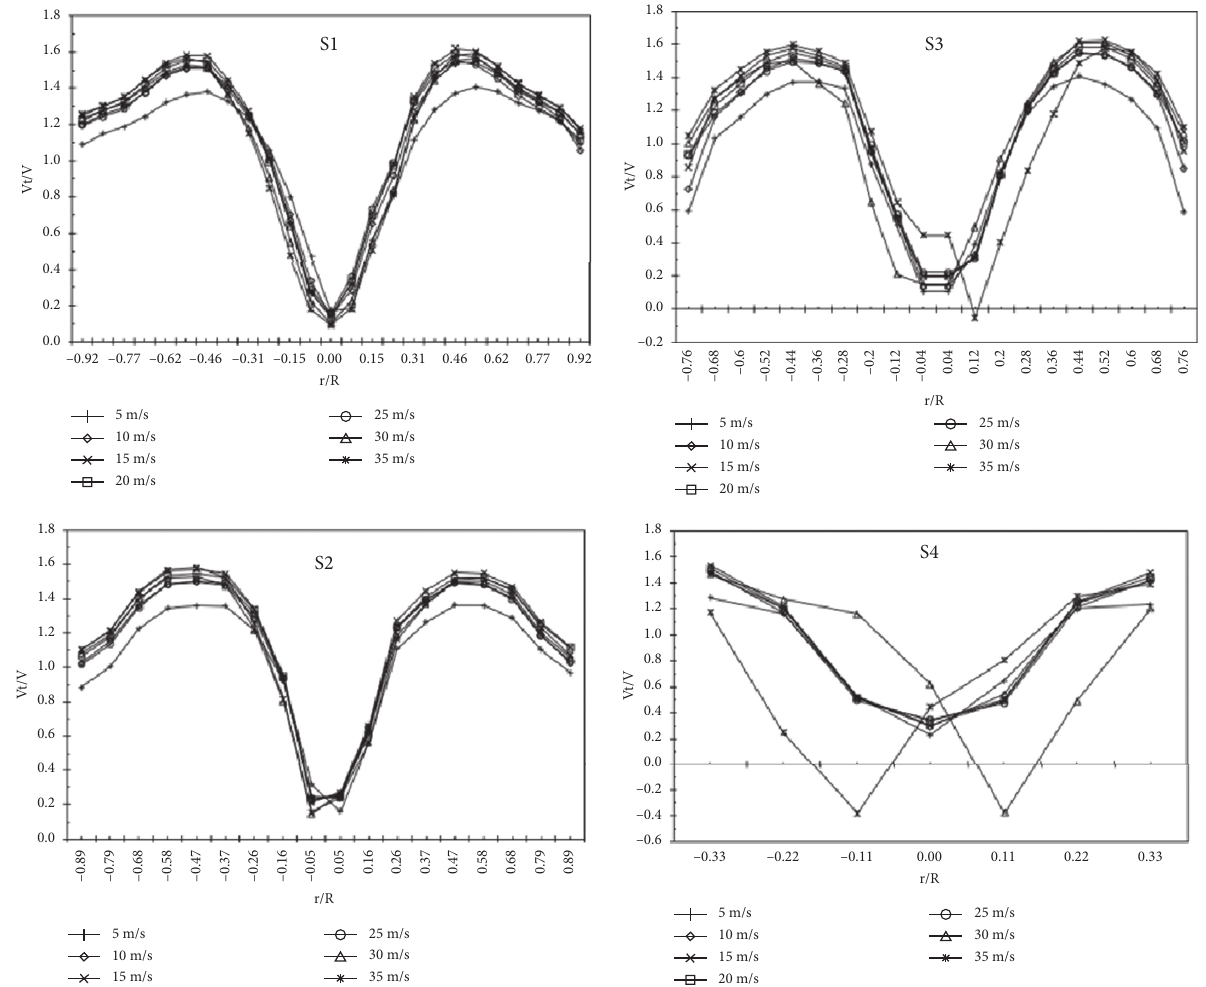
Figure 4: Tangential velocity profiles at different axial locations and inlet exceeds 30 m/s, as shown in the axial velocity contours in Figure 7. The inner vortex of the separator becomes un- stable and is no longer axis symmetric near the exit of the conical part, which is due to the strong coupling between the axial and tangential velocity components and the swirls. The results also show that the axial velocity is negative in the outer vortex (from green to blue) and positive in the inner vortex (from green to red). The interface between these two vortices is located at the point where the axial velocity is zero. The distance between the vertical centre of the separator and this interface is expected to decrease along with the radius in the conical part of the separator.